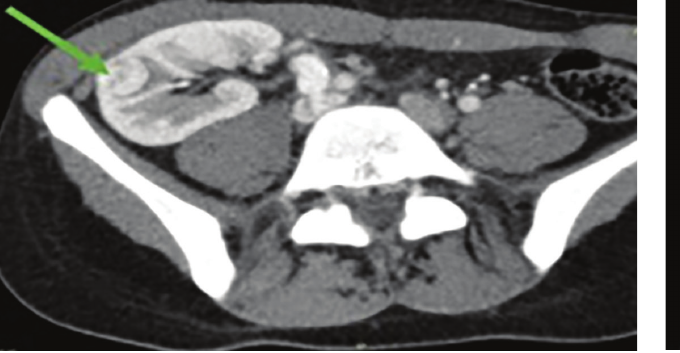
a) The size of the lesion (measured and marked with arrows) b) Lesion in renal allograft (marked with arrow)